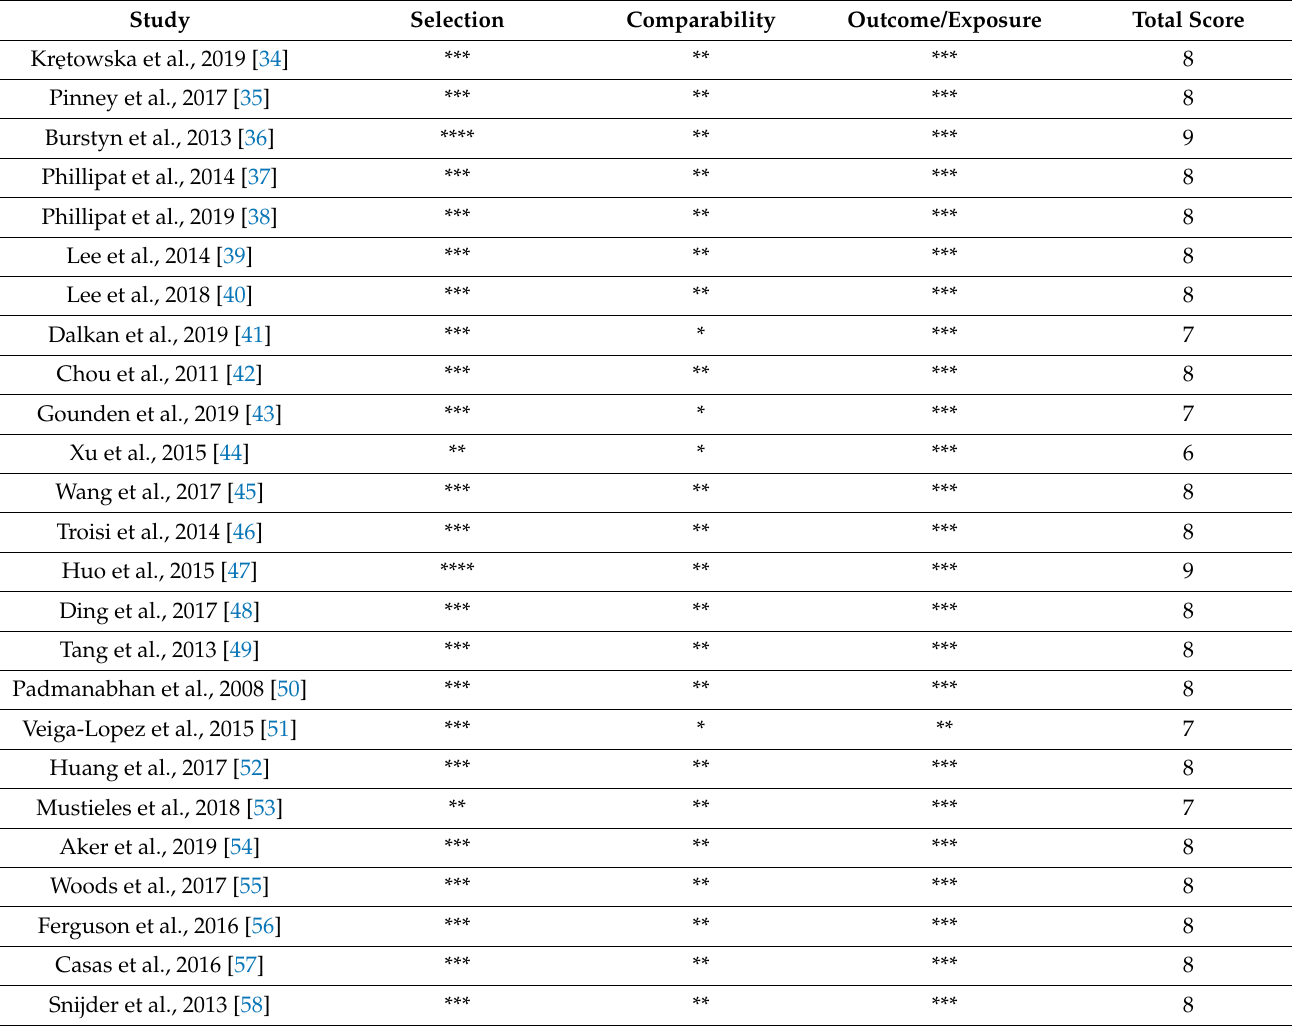
Table 1. Quality assessment of the included studies based on the Newcastle–Ottawa